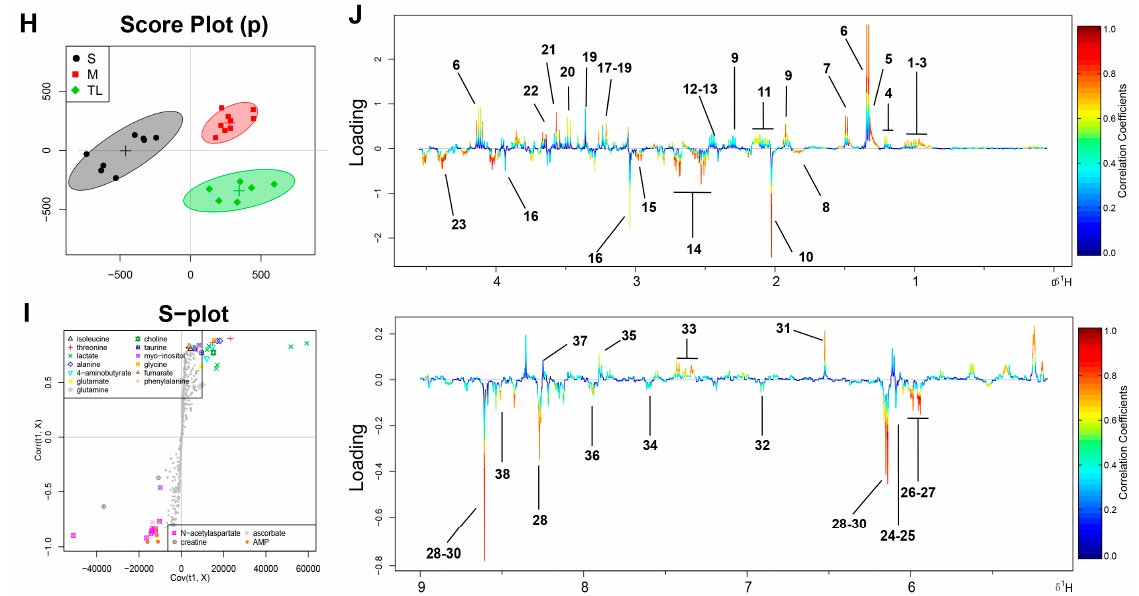
Figure 2. OSC-PLSDA analysis of the brain metabolic profiles between sham, model and TH/TM/TL groups. ( A ) Typical 500 MHz 1 H NMR spectra of brain extracts with the metabolites labeled for all groups. Metabolites: 1, isoleucine; 2, leucine; 3, valine; 4, 3-hydroxybutyrate; 5, 2-hydroxyisobutyrate; 6, lactate; 7, alanine; 8, lysine; 9, 4-aminobutyrate; 10, N-acetyl aspartate; 11, glutamate; 12, succinate; 13, glutamine; 14, aspartate; 15, trimethylamine; 16, creatine; 17, choline; 18, phosphocholine; 19, taurine; 20, myo-inositol; 21, glycine; 22, threonine; 23, ascorbate; 24, adenosine; 25, inosine; 26, uridine; 27, uracil; 28, AMP; 29, ADP; 30, ATP; 31, fumarate; 32, tyrosine; 33, phenylalanine; 34, niacinamide; 35, histidine; 36, xanthine; 37, oxypurinol; 38, formate; consistent with Supplementary Table S1. ( B , E , H ) OSC-PLSDA score plots. ( C , F , I ) OSC-PLSDA S-plots. ( D , G , J ) Color-coded coefficient loading plots. Blue: Lowest, no statistically significant difference between the groups; red: Highest, statistically significant. Metabolites are numbered consistently with those in Figure